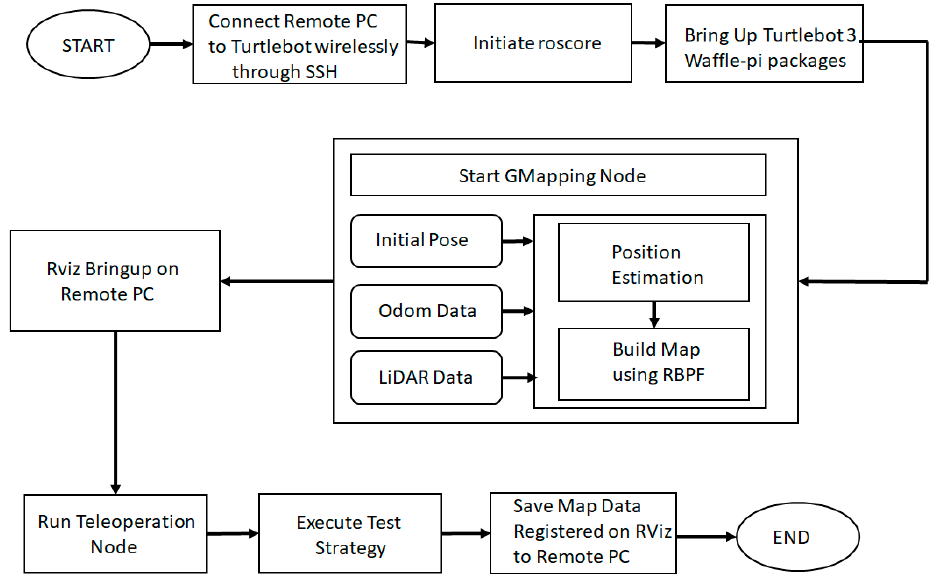
Figure 5. Process of data collection by the mobile robot to build a map using ROS tools.